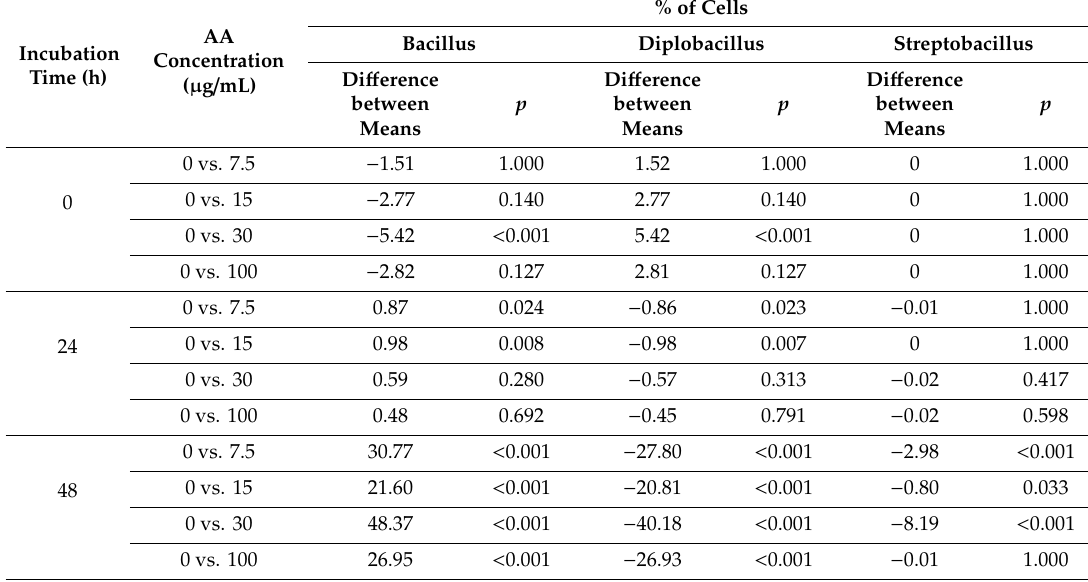
Table 8. The interaction e ff ect of incubation time and concentration of acrylamide on the morphology of Lactobacillus plantarum (Bonferroni